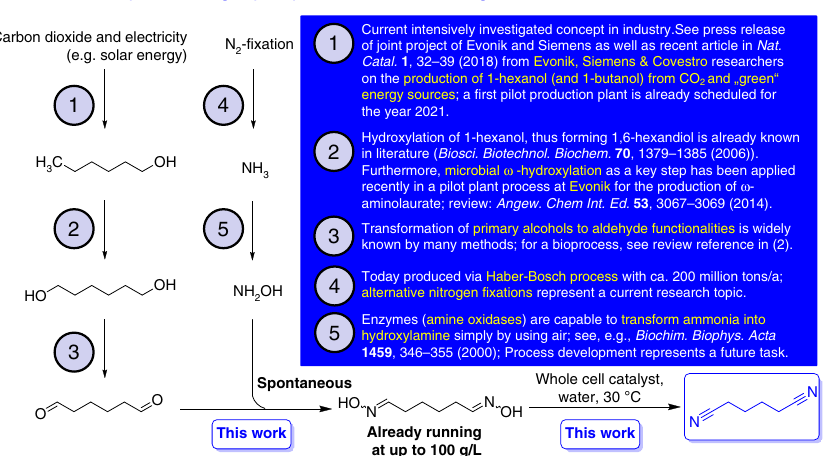
Fig. 7 Overall concept for producing adiponitrile based on biorenewable feedstocks. Adipaldehyde may be synthesized starting from CO 2 and solar energy in the future (step 1, 2, and 3) and the required hydroxylamine may be obtained by nitrogen fi xation and subsequent selective oxidation of ammonia (step 4 and 5). Afterwards, the dioxime synthesis and biocatalytic dehydration would give access to adiponitrile based on completely renewable resources